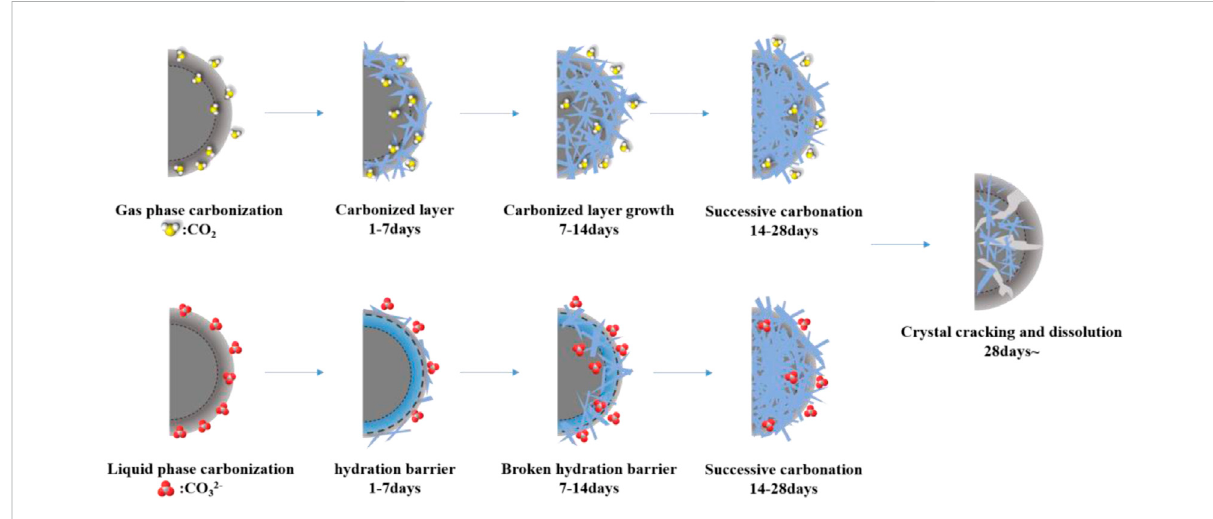
FIGURE 11 Schematic diagram of CO 2 carbonization process of C 3 S single-phase